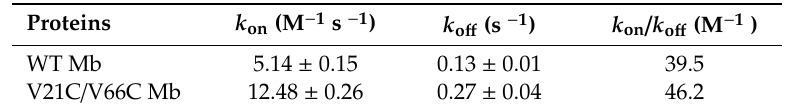
Table 1. Comparison of the kinetic parameters of fluoride binding to WT Mb and the double mutant of V21C / V66C Mb with an intramolecular disulfide